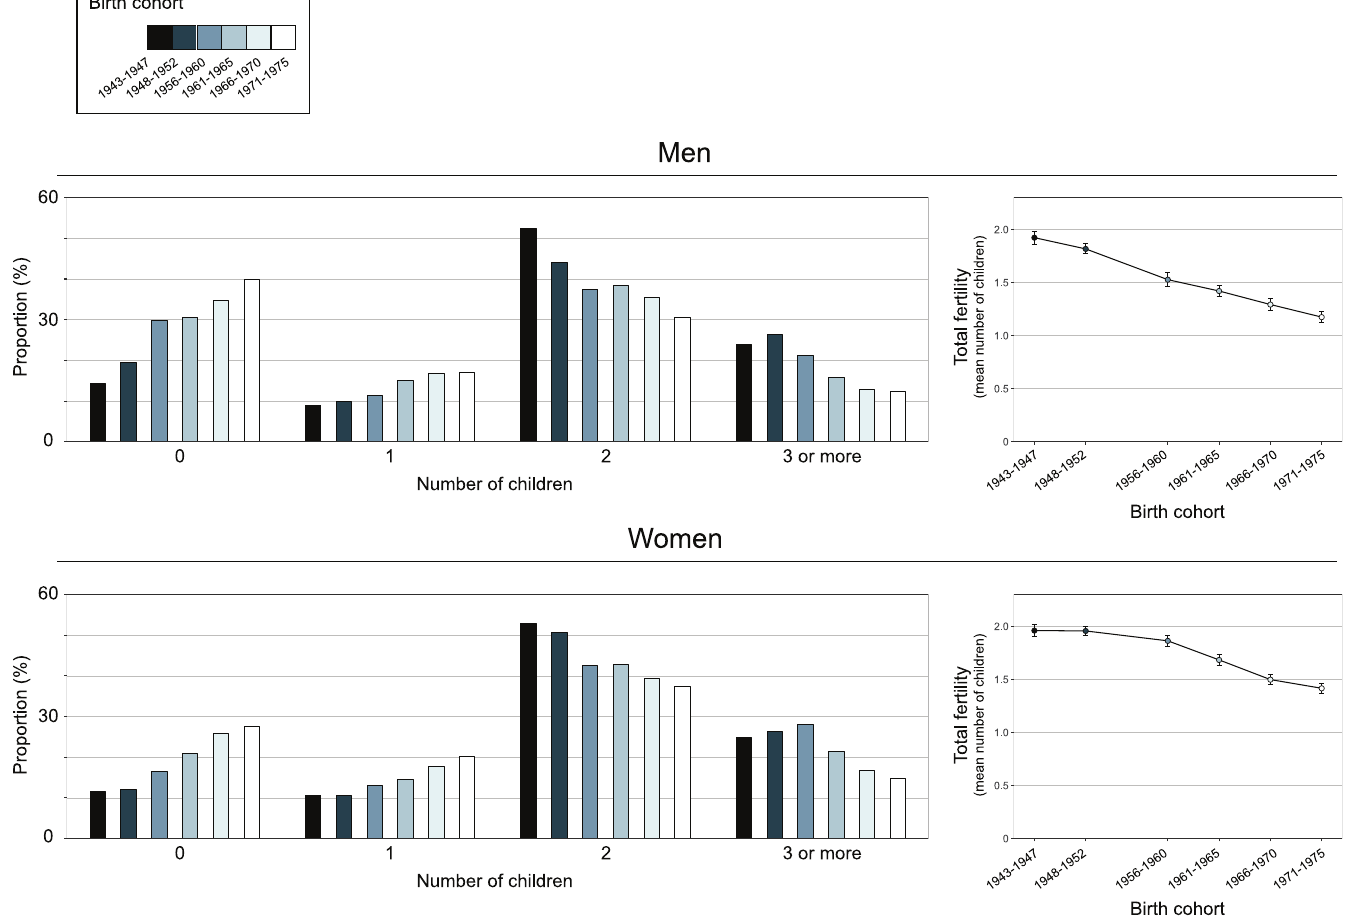
Fig 1. Trends in the distribution of number of children and total fertility across birth